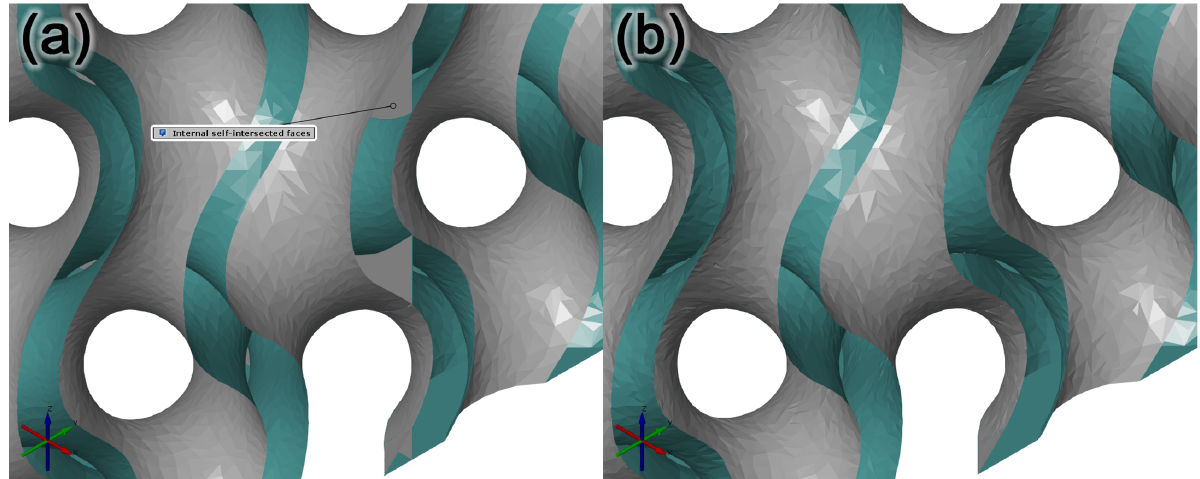
Figure 10. Model with the non-manifold geometry repaired. ( a ) Illustration of self-intersected surfaces inside the cellular structure model; ( b ) illustration of how deficiency was repaired.